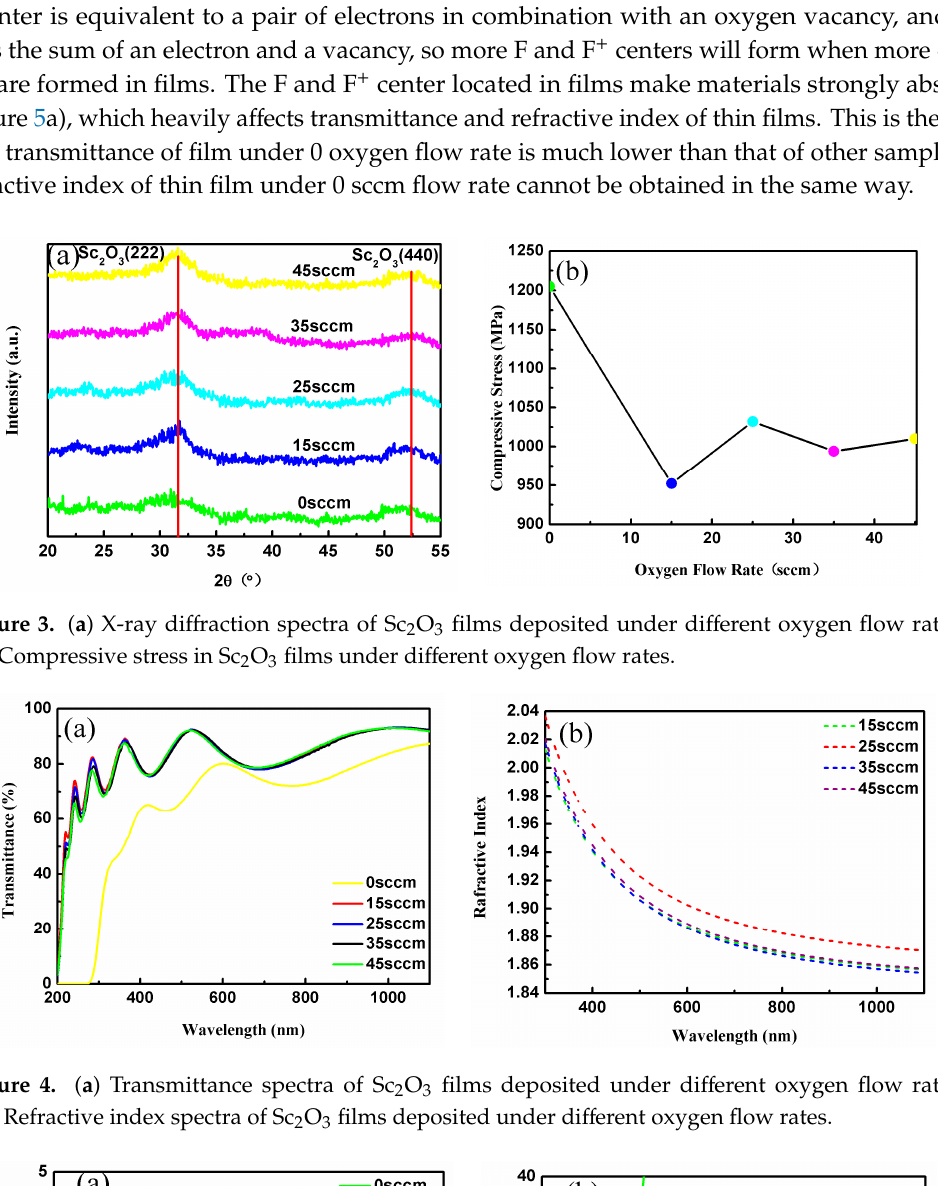
Figure 3. ( a ) X-ray diffraction spectra of Sc 2 O 3 films deposited under different oxygen flow rates; ( b ) Compressive stress in Sc 2 O 3 films under different oxygen flow rates.